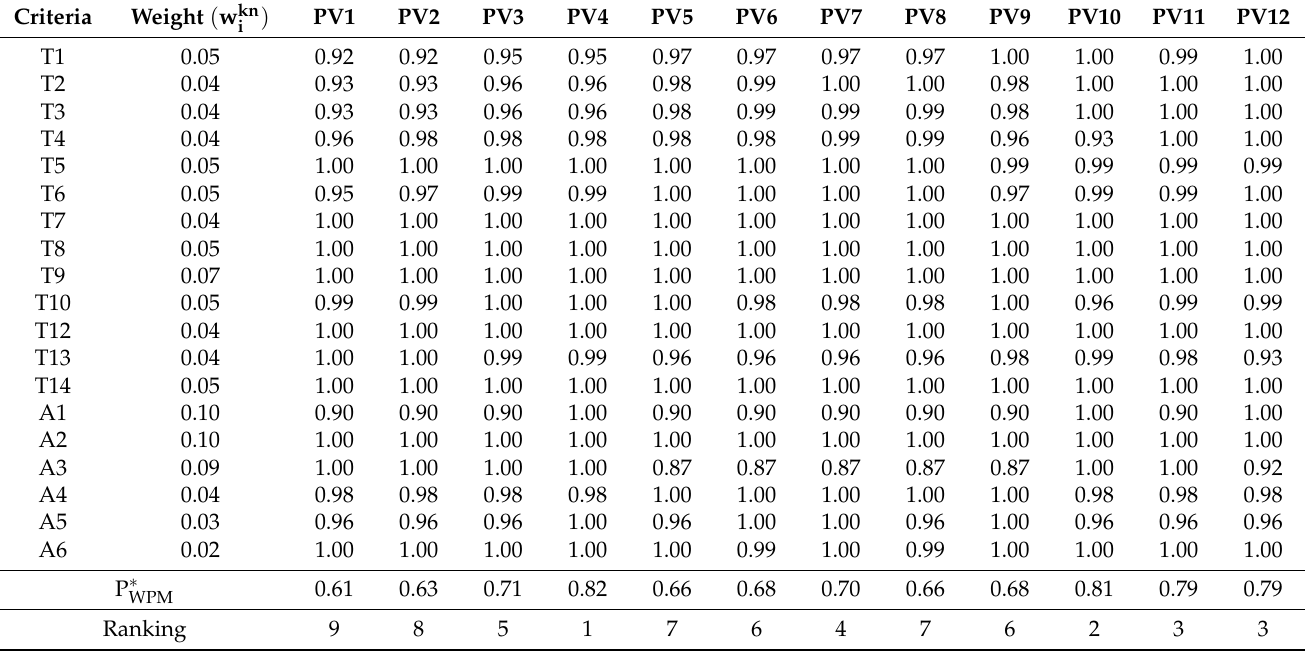
Table 16. PV quality according to the WPM method. Own